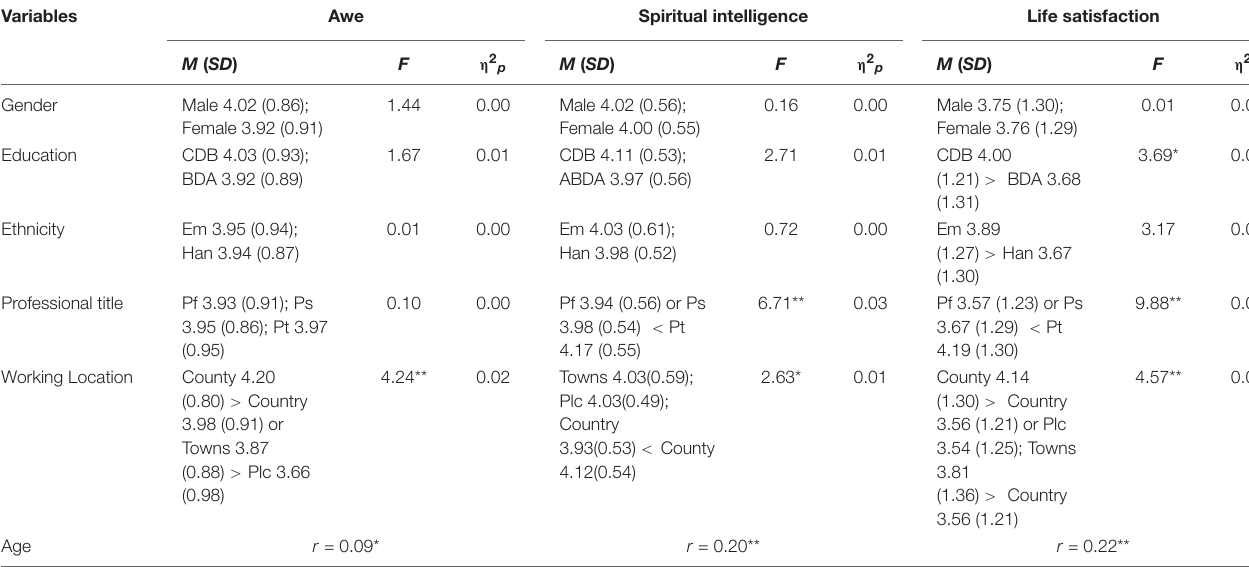
TABLE 1 | Demographic differences in awe, spiritual intelligence, and life satisfaction. Variables Awe Spiritual intelligence